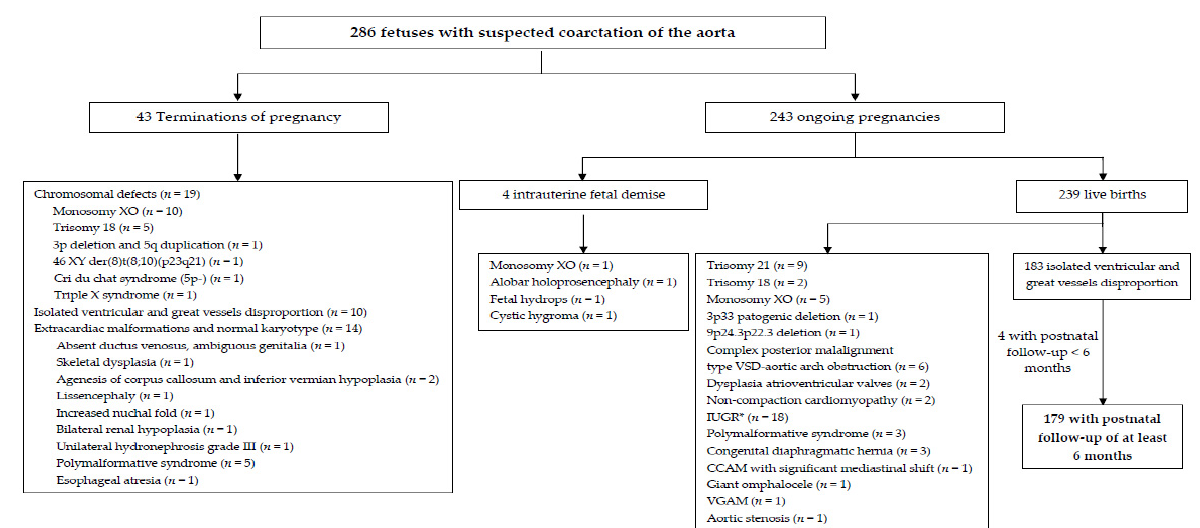
Figure 1. Flow chart of fetuses with cardiac asymmetry according to the selection criteria. CCAM, congenital cystic adenomatoid malformation; IUGR, intrauterine growth restriction; VGAM, vein of Galen aneurysmal malformation; VSD, ventricular septal defect. * Diagnosis of IUGR was made before suspected coarctation of the aorta.